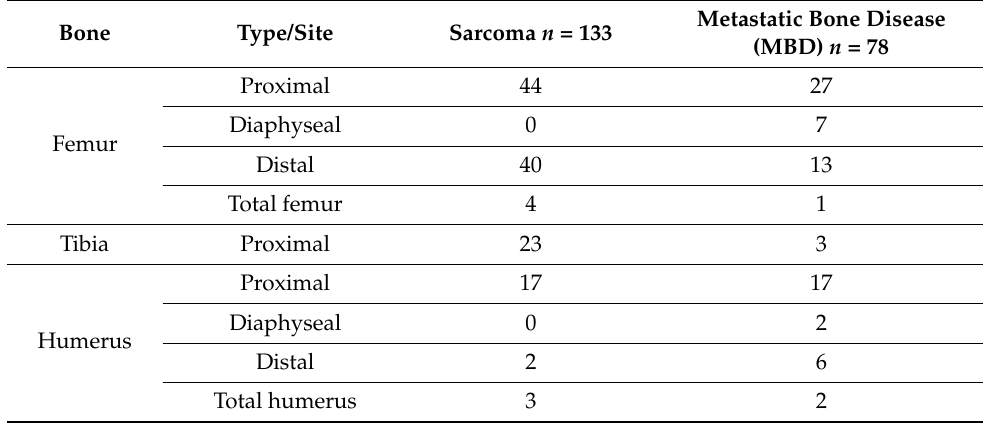
Table 2. Summary of site per